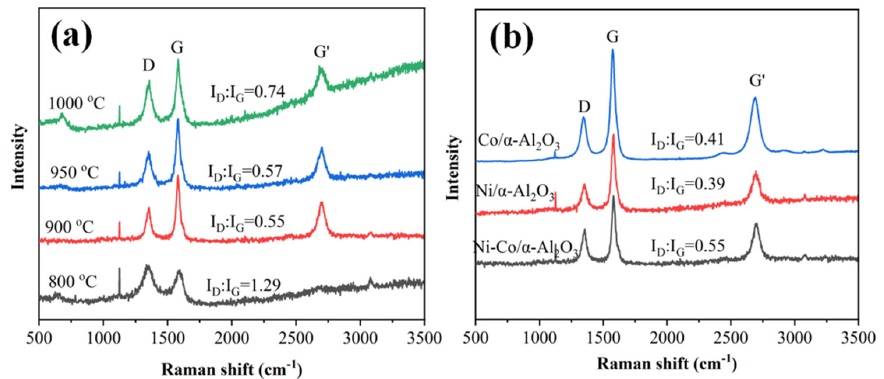
Figure 13. Raman spectra of CNCs synthesized ( a ) at 800 °C, 900 °C, 950 °C, and 1000 °C with the NiCo/ α –Al 2 O 3 catalyst; and ( b ) with the Ni/ α –Al 2 O 3 , NiCo/ α –Al 2 O 3 , and Co/ α -Al 2 O 3 catalysts at 900 °C.